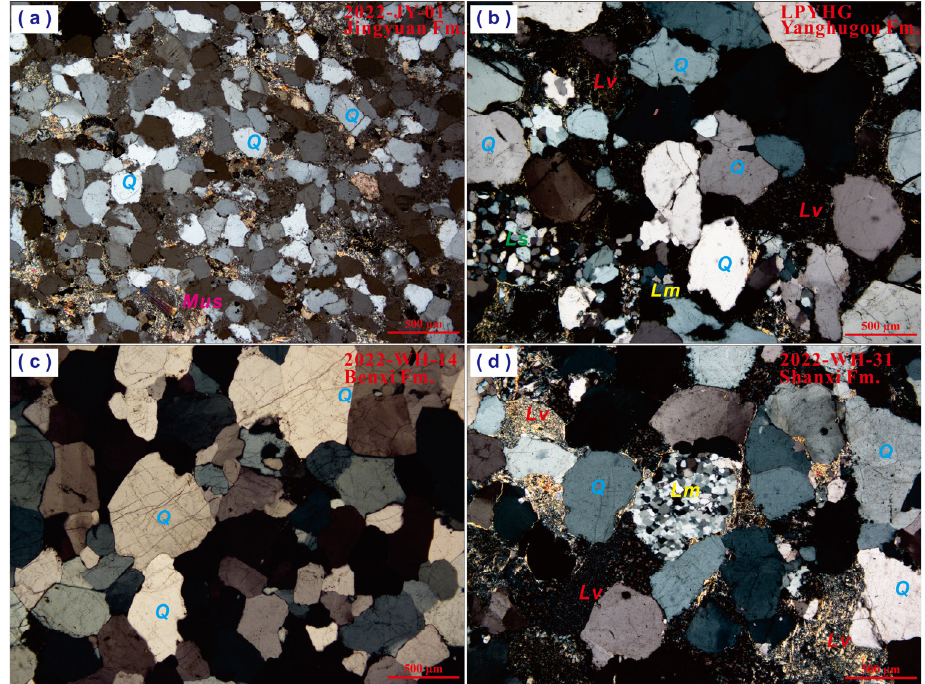
Figure 6. Representative photomicrographs (cross ‐ polarized light) of Carboniferous to Lower Permian sandstone samples selected for detrital zircon U ‐ Pb geochronology. Sample locations are shown in Figure 2a. See the Supplementary Table S1 for abbreviations of minerals. Sample labels: ( a ), 2022 ‐ JY ‐ 01; ( b ), LPYHG; ( c ), 2022 ‐ WH ‐ 14; ( d ), 2022 ‐ WH ‐ 31. Abbreviations: Q, Quartz; Lv, volcanic lithics; Lm, metamorphic lithics; Mus, Muscovite.